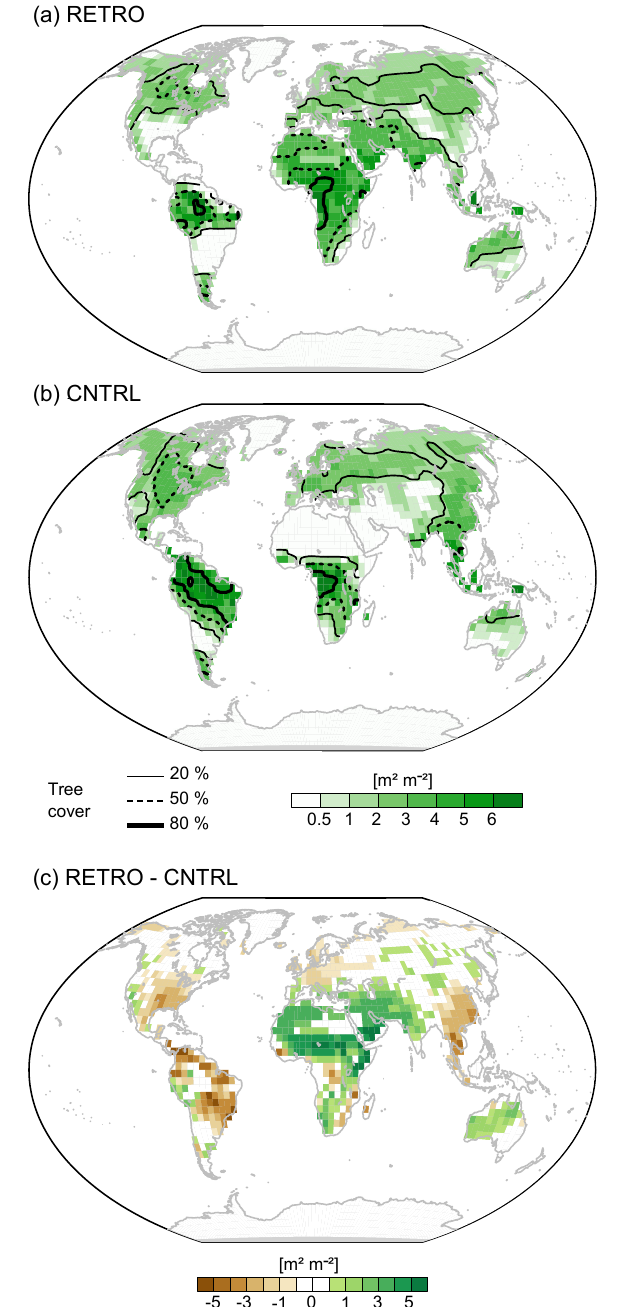
Figure 11. LAI (shaded) and tree cover (contours) for (a) RETRO and (b) CNTRL. Panel (c) shows the differences in LAI (see also video in